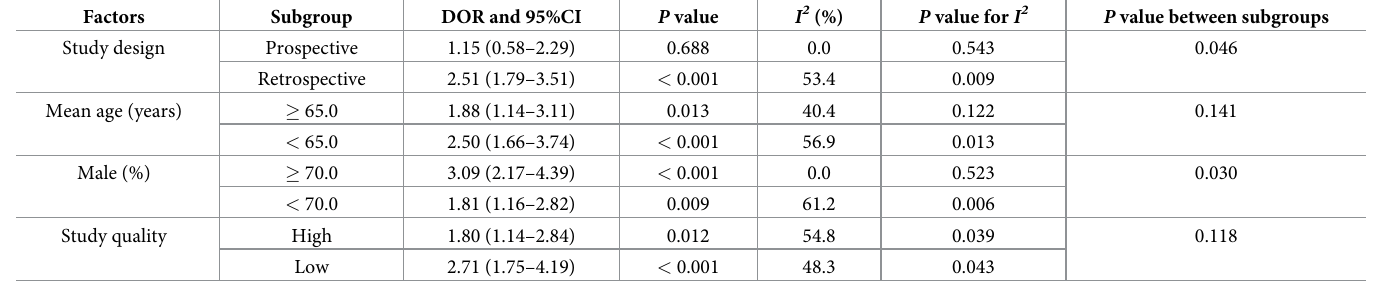
Table 2. Subgroup analyses for the predictive value of pulmonary embolism for ICU admission.